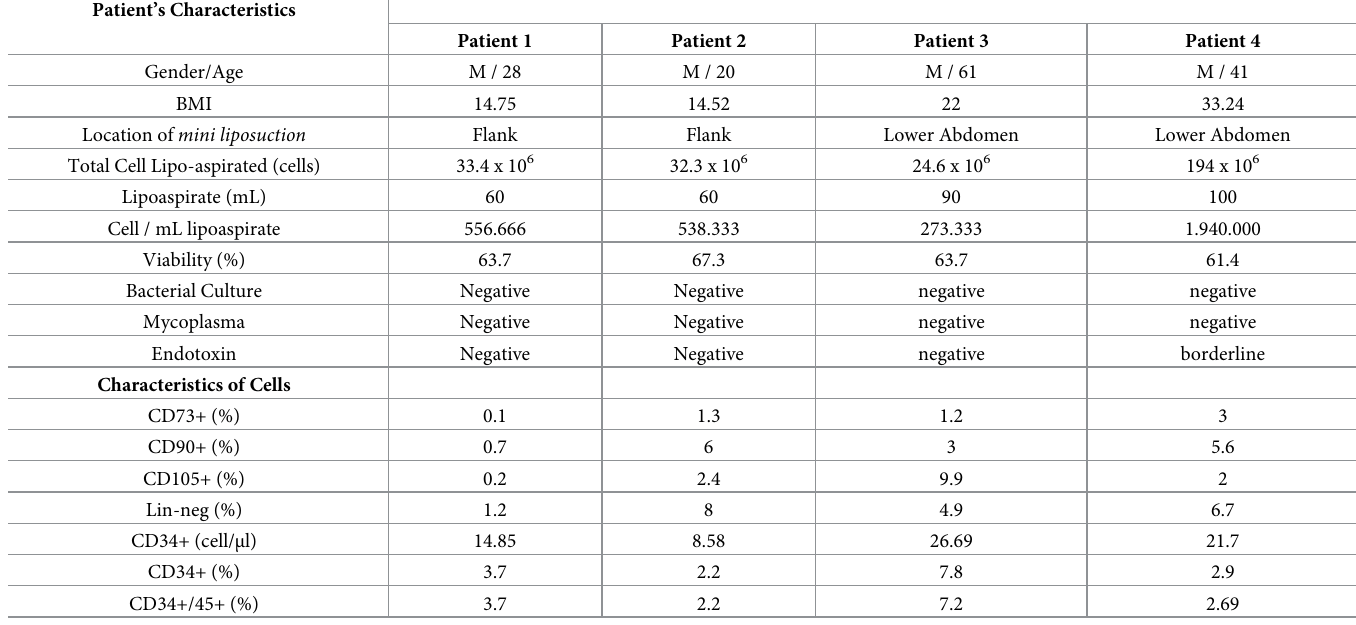
Table 1. Clinical, Lipoaspirate and Cells